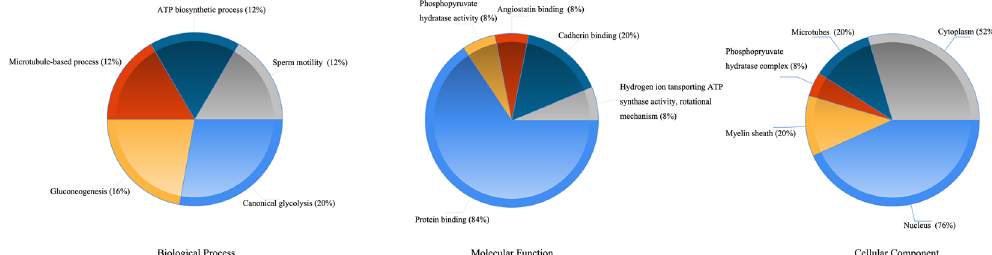
Figure 3. Gene Ontology analysis of the identified proteins. The top 5 biological process, molecular function and cellular component were shown in pie chart.